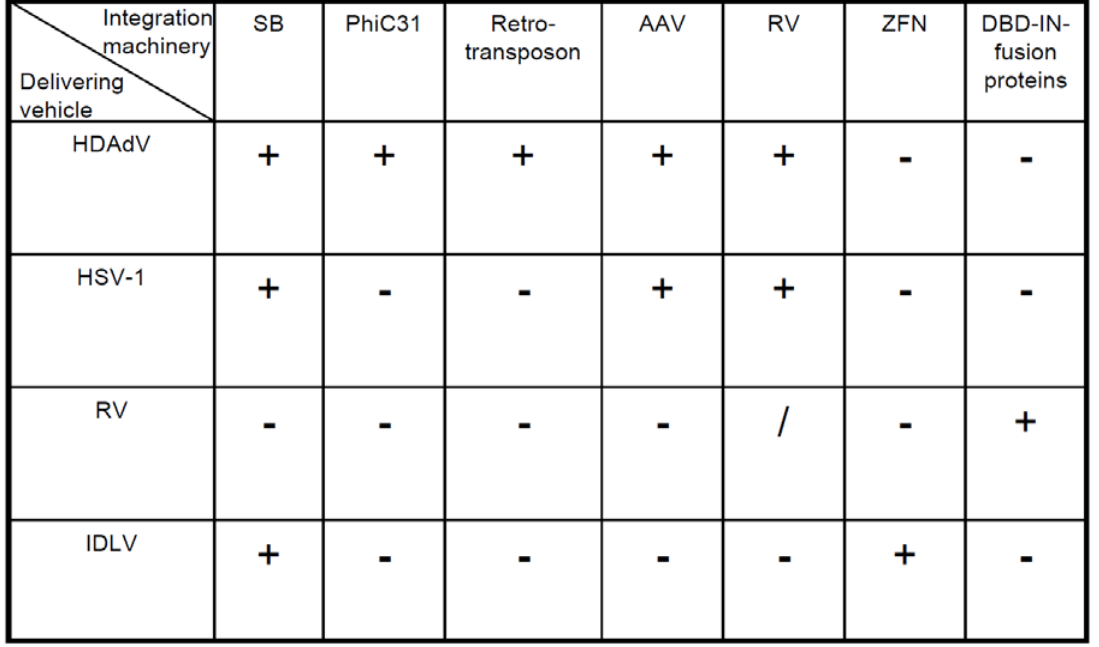
Table 1. State-of-the-art of hybrid vector technologies. The mentioned delivery systems are helper-dependent adenovirus (HDAdV), herpes simplex virus type 1 (HSV-1), retrovirus (RV), and integrase defective lentivirus (IDLV). Integration machineries used in combination with these delivery vehicles are Sleeping Beauty (SB) transposase, bacteriophage integrase PhiC31, retrotransposon, adeno-associated virus (AAV; AAV-ITR or AAV-Rep protein-mediated), retrovirus (RV; LTR-mediated or retrovirus integrase mediated), zinc-finger nuclease (ZFN), and DNA-binding domain-retroviral integrase- fusion proteins (DBD-IN fusion proteins). (+) represents the existing combination of the respective integration machineries and the delivering vector. (-) represents non-existing viral hybrid vector